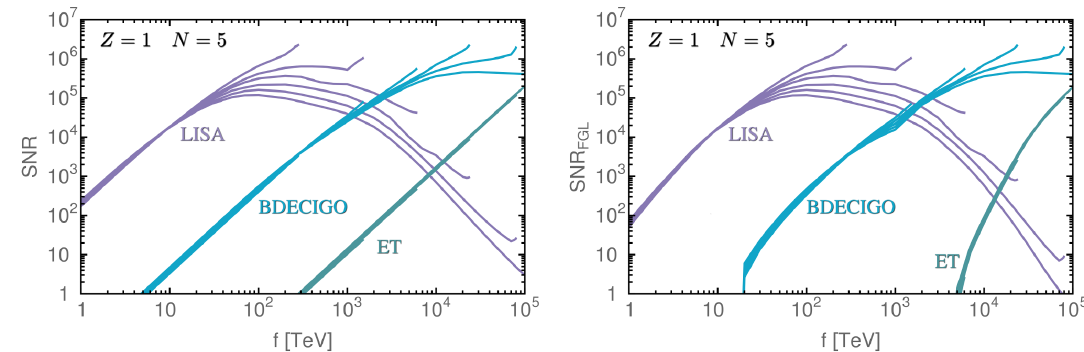
Figure 9 . The signal-to-noise ratio estimated for future measurements at LISA, BDECIGO, and ET. The curves have been calculated for Z = 1 and m = 0 . 17 f , 0 . 18 f , 0 . 19 f , 0 . 20 f , 0 . 21 f , 0 . 22 f σ (from top to bottom). The curves terminate when the universe becomes stuck in the false vacuum. The plot on the right assumes degradation of the achievable signal due to white dwarf and neutron star binaries, cf. eq. (5.8). Even without foreground subtraction, the entire parameter space of this scenario can be tested with a combination of these